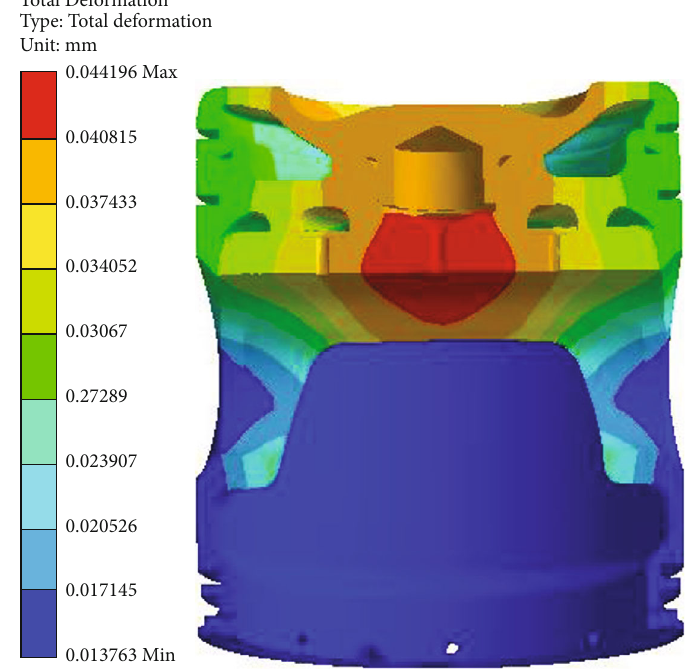
Figure 9: The deformation nephogram of the piston under mechanical stress condition.